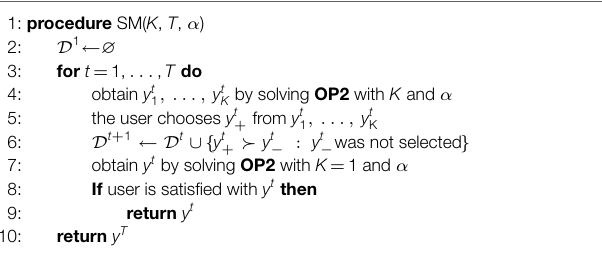
Algorithm 2 | The Setwise Max-margin algorithm.